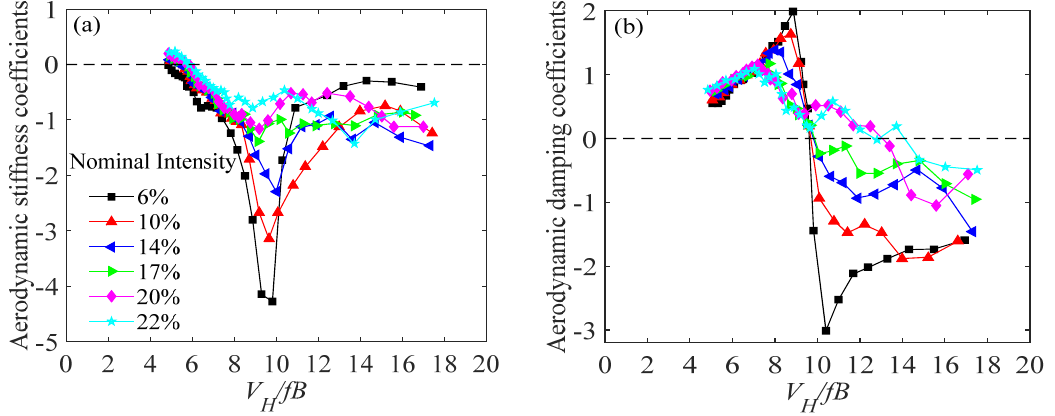
Figure 13. Aerodynamic stiffness and damping coefficients of a prism ( a ) aerodynamic stiffness coefficients; ( b ) aerodynamic damping coefficients, after [10].